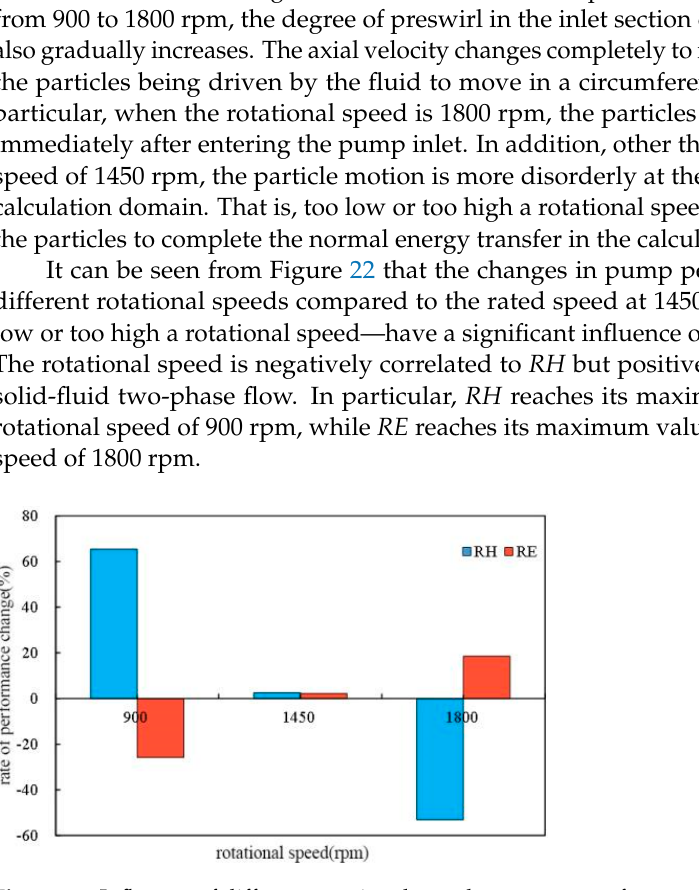
The relationship between the head and rotational speed in the affinity law can be expressed by Equation (20), as follows: